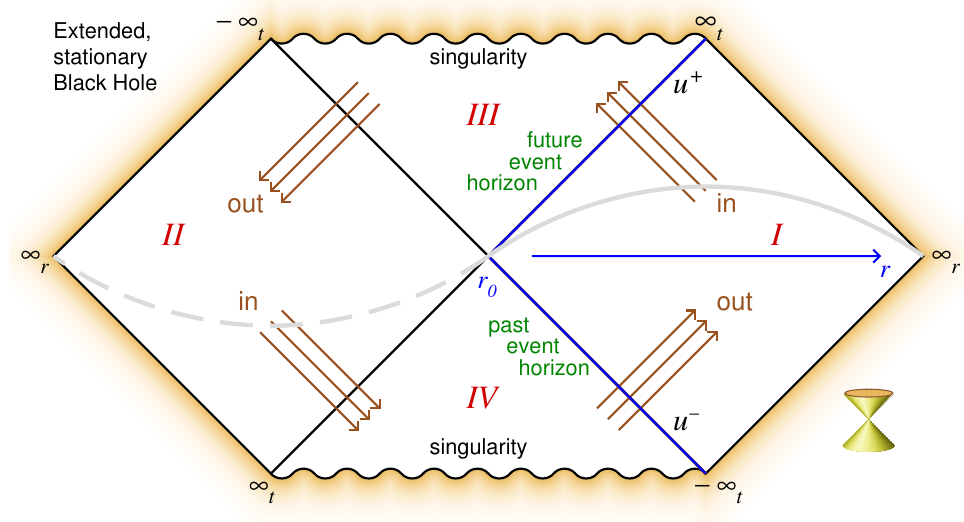
Figure 1. Penrose diagram showing regions I – IV . In- and out-particles can punch through a horizon at positive values of u ± (region I ), or negative u ± (region II ). Grey curve: Cauchy surface. Dashed curve: cloned